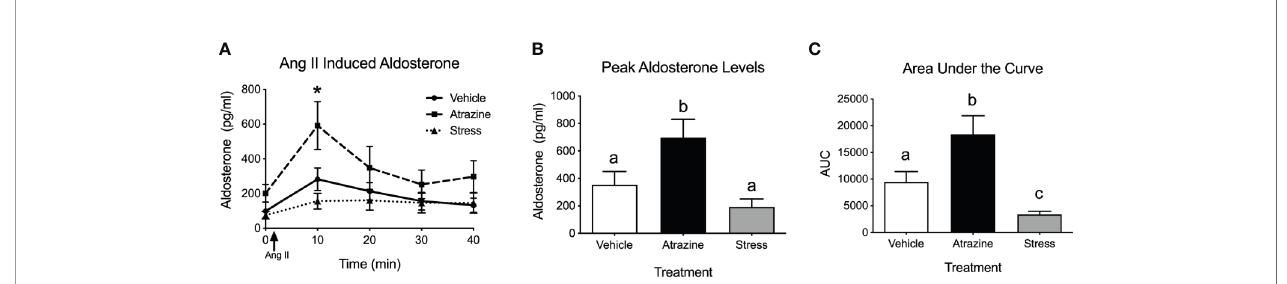
FIGURE 2 | Atrazine treatment increases circulating aldosterone concentrations after angiotensin II (Ang II). (A) Line graph depicting aldosterone concentrations before and after infusion of Ang II in vehicle, atrazine (100mg/kg), and restraint stressed animals after 4 days of treatment. Arrow indicates timing of Ang II (5 µg/kg of BW). Histograms depicting (B) peak aldosterone concentrations and (C) area under the curve levels in vehicle, atrazine (100mg/kg), and restraint stressed animals after 4 days of treatment. Data presented as the mean ± SEM. Asterisk signi fi es difference from control group ( P < 0.05). Letters denote signi fi cant difference between